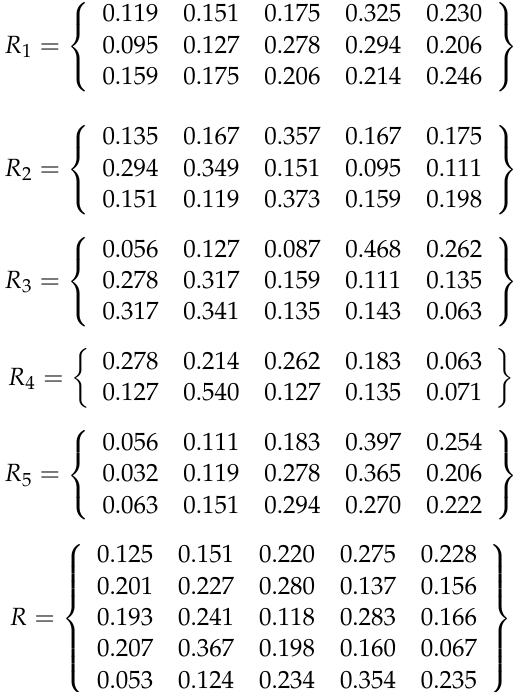
The expert weights were determined through the questionnaires administered to the experts, based on which the fuzzy judgement matrices R i and R of the first- and second-level indicators were established using an FCE method: